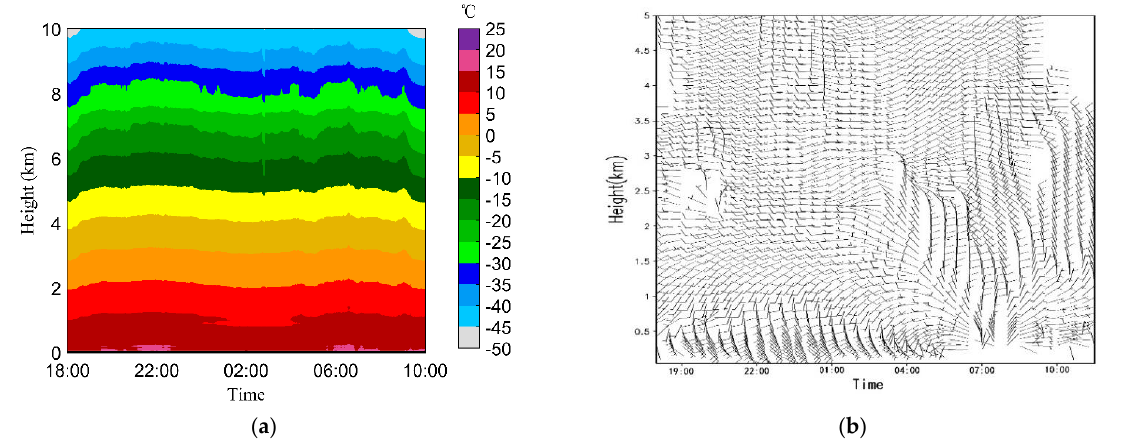
Figure 9. Time – height cross-sections of temperature ( a ) detected by MWR and wind profiles ( b ) detected by WPR from18:00 on18 August-10:00 on 19 August 2021 in YJP station. The vertical evolution of DSD every 2 min between 5:00 and 5:22 is shown in Figure 10. We note that when the ‘bulge’ in the upper air collided and fell at 5:06, a belt of falling large particles fell to 1 to 2 km rapidly, and the DSD showed a bimodal distribution (marked with red rectangle). This revealed the instantaneous aggregation, collision, growth, and descent of the large raindrops. From 5:08 to 5:12, the DSD still showed a bi- modal distribution from the ground to approximately 1.5 km. Meanwhile large particles